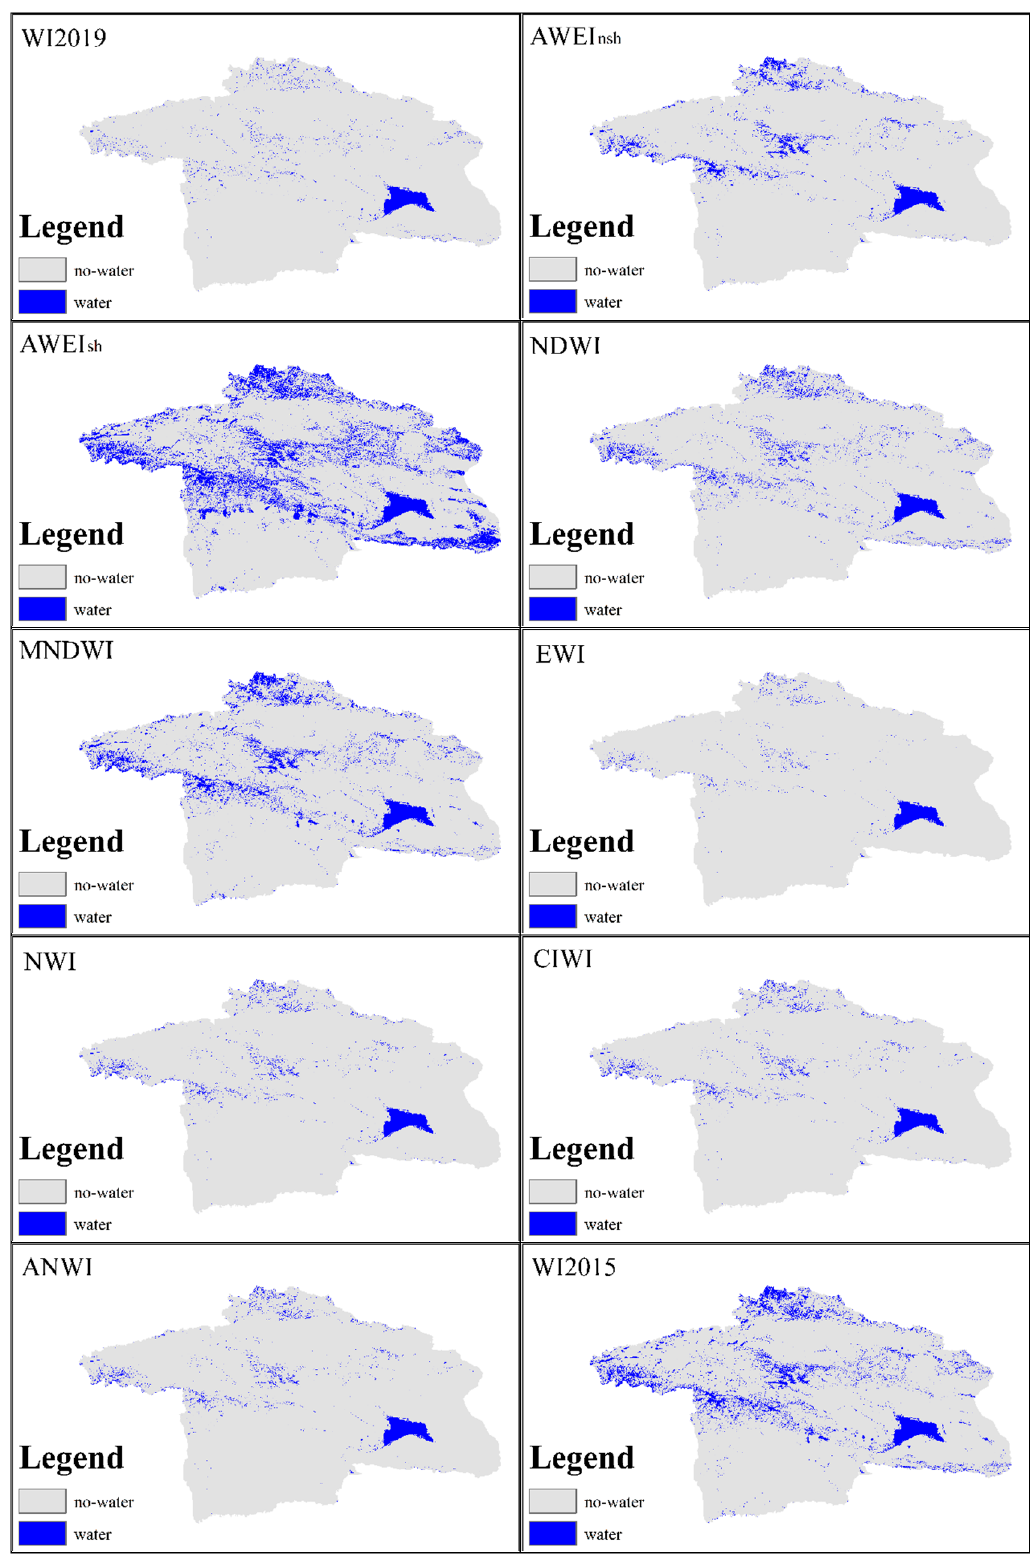
Figure 5. Each water index takes 0 as the threshold value to extract surface water results.